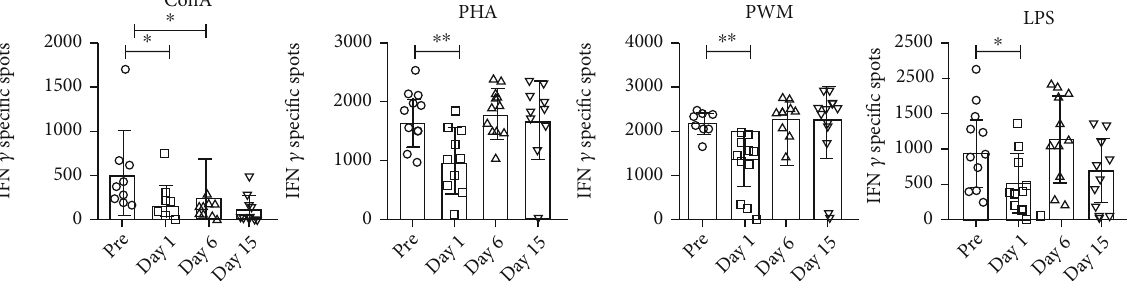
Figure 5: ELISpot for detecting mitogen-speci fi c IFN γ -producing cells in squirrel monkeys. Triplicate wells of the 96-well microtiter plates, precoated with IFN γ antibody, were seeded with 10 5 PBMCs, stimulated with 1 μ g of each of the mitogens for 36h at 37 ° C, and then washed and stained with biotinylated second IFN γ antibody. The total number of spots forming cells (SFCs) in each of the mitogen-stimulated wells was counted and adjusted to control medium as background. See Materials and Methods for experiment details. p values were considered statistically signi fi cant at p < 0 : 05